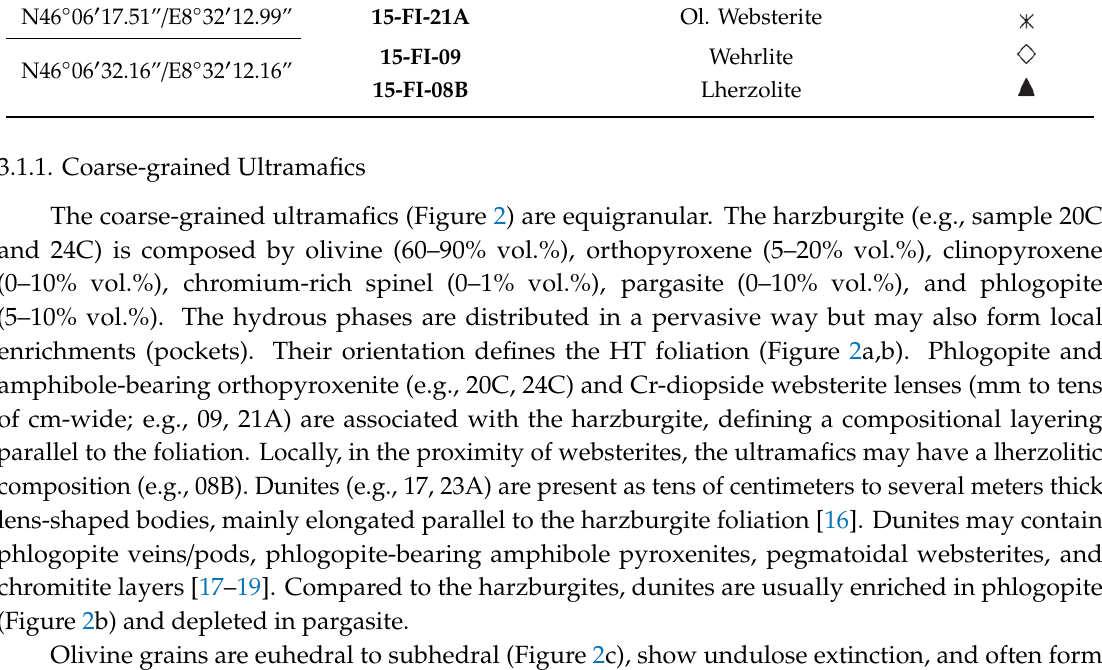
Table 1. Labels, GPS coordinates (WGS84), lithologies of samples, and relative symbols used in diagrams.